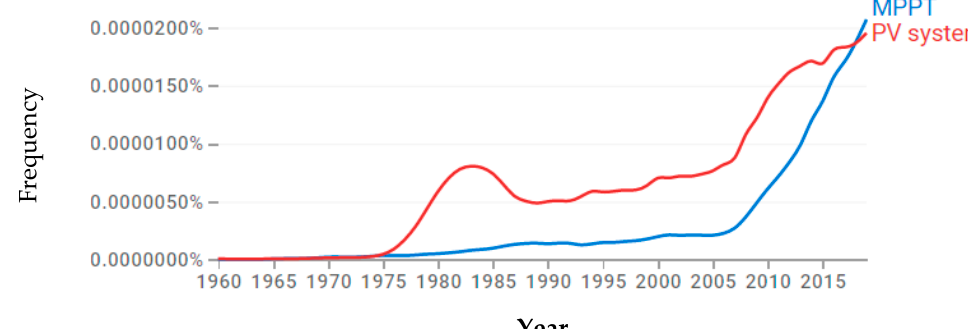
Figure 4. Frequency of contrasting word types of MPPT algorithms from 1960 to 2019.